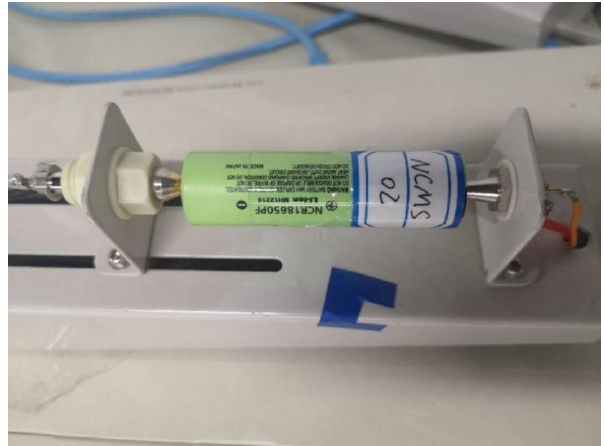
Figure 2. The 18650 lithium-ion battery for